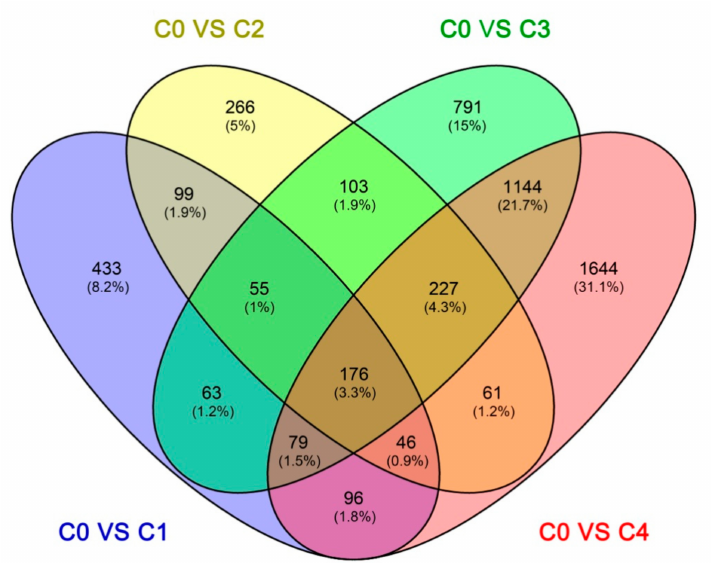
Figure 4. The number of DEGs expressed at one cold stress time point and at overlapping time points, compared with the control. C0, C1, C2, C3, and C4 represent 0, 2, 6, 24, and 48 h,